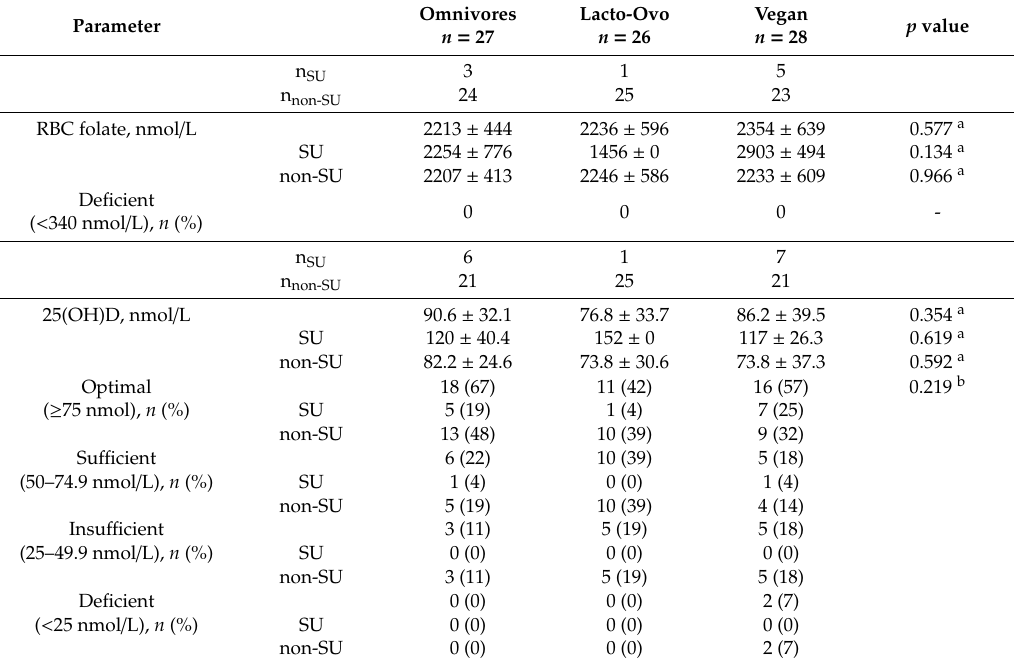
Table 3. Biomarkers of folate and vitamin D